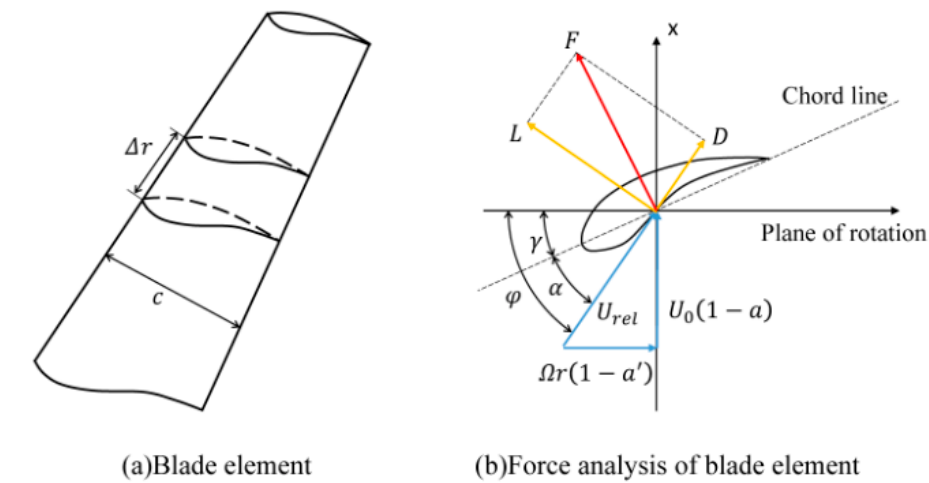
Figure 3. Schematic of BEM, ( a ) blade element; ( b ) force analysis of blade element.